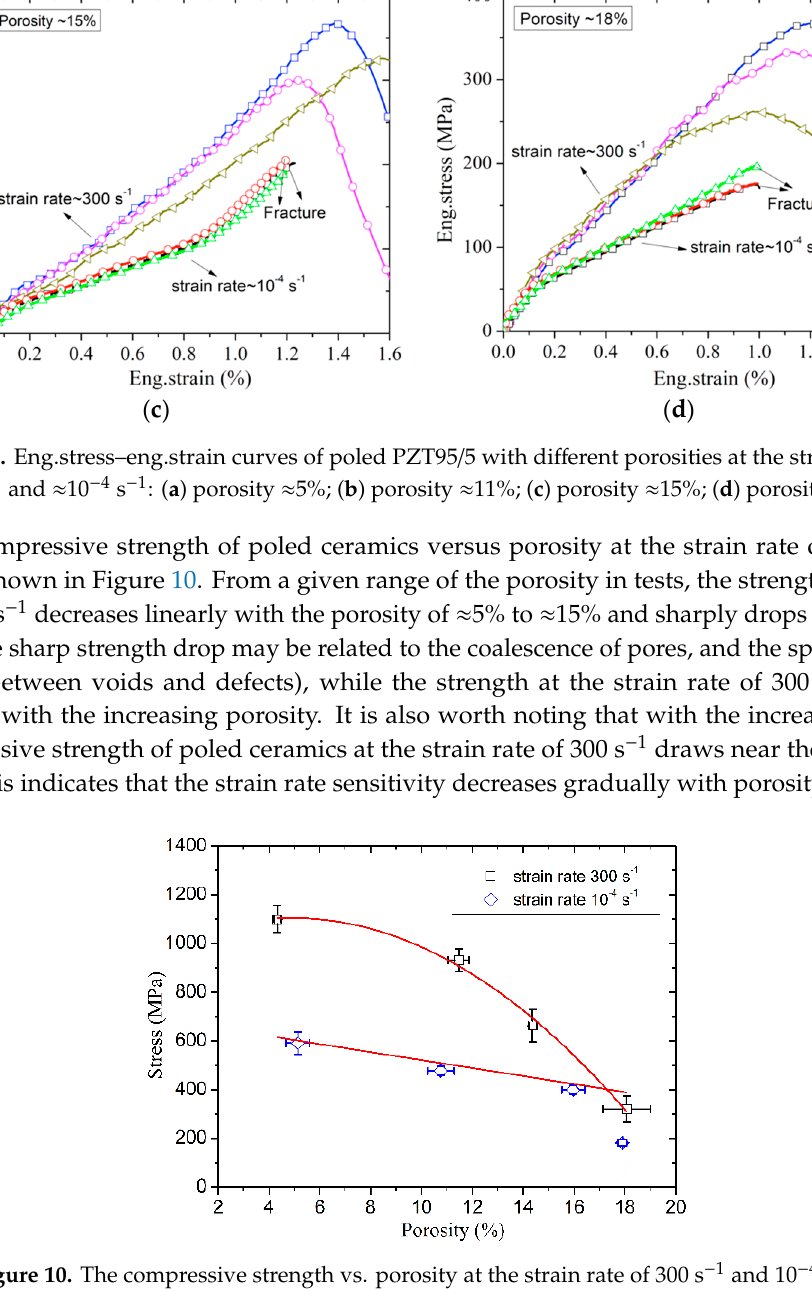
with ≈ 18% porosity. Therefore, the values of σ P for the samples with ≈ 18% porosity are not shown in Figure 11. The normalized σ D and σ P at the 10